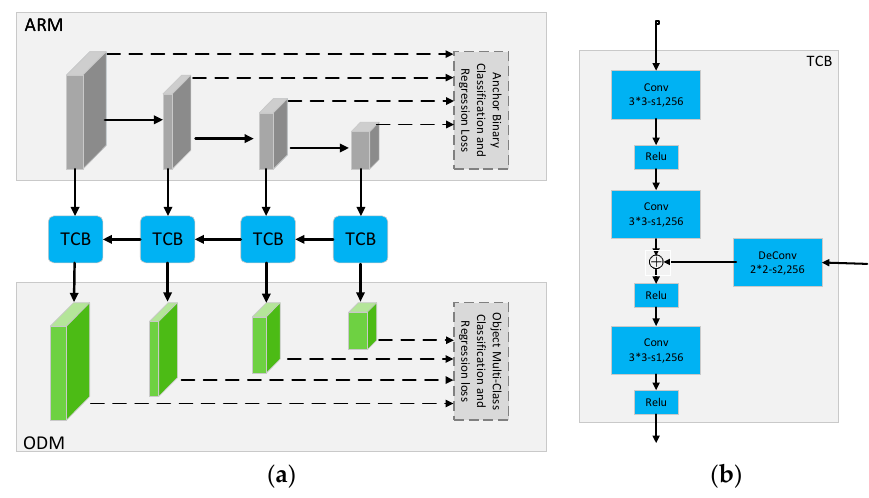
Figure 1. The main structure of the original RefineDet. ( a ) The ARM, TCB, and ODM of original RefineDet; ( b ) Description of TCB structure. RefineDet; ( b ) Description of TCB structure.